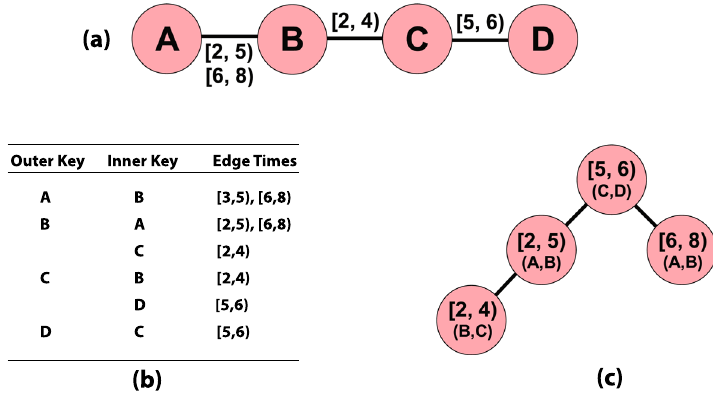
Fig. 1 a Sample temporal network with 4 nodes and 3 edges. Labels on edges denote time intervals at which the edges are active. Our proposed hybrid data structure represents this network using b an adjacency dictionary and c an interval